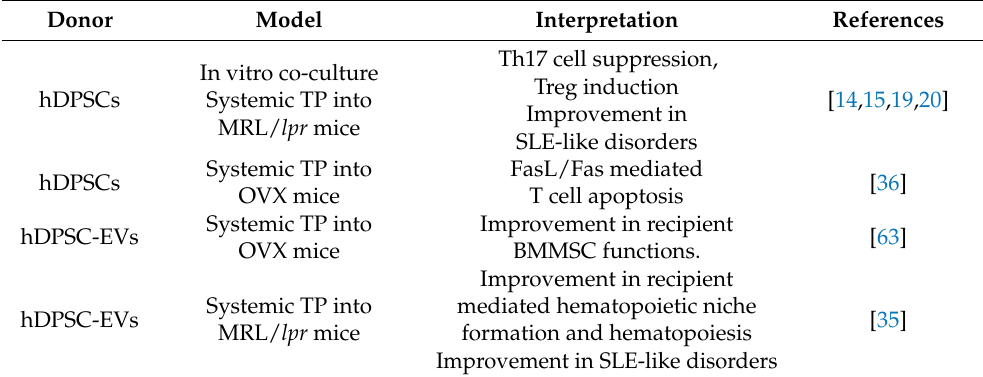
Table 2. Key studies in hDPSC-based therapy for systemic lupus erythematosus (SLE). Donor